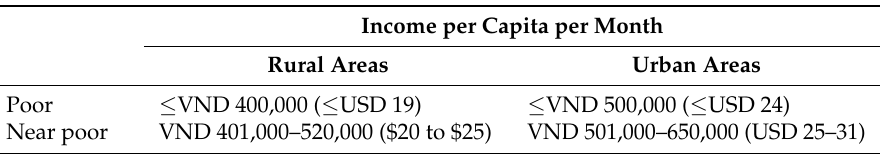
Table 3. Poverty line of Vietnam in rural and urban areas.